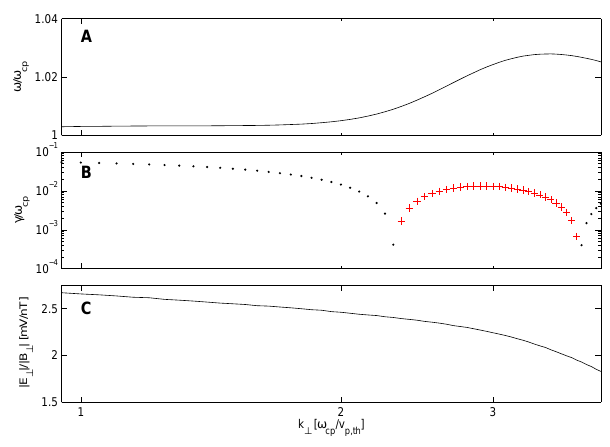
Fig. 9. Ion cyclotron mode obtained from WHAMP with proton shell and Maxwellian electron distributions modeled from particle measurements. (a) Frequency vs. perpendicular wavenumber. (b) Imaginary part of frequency vs. perpendicular wave number. Black dots stand for γ< 0 (damping) and red crosses for γ> 0 (growth). (c) E ⊥ /B ⊥ -ratio. The parallel wave number was k || = 0.1 ω cp /v p,th